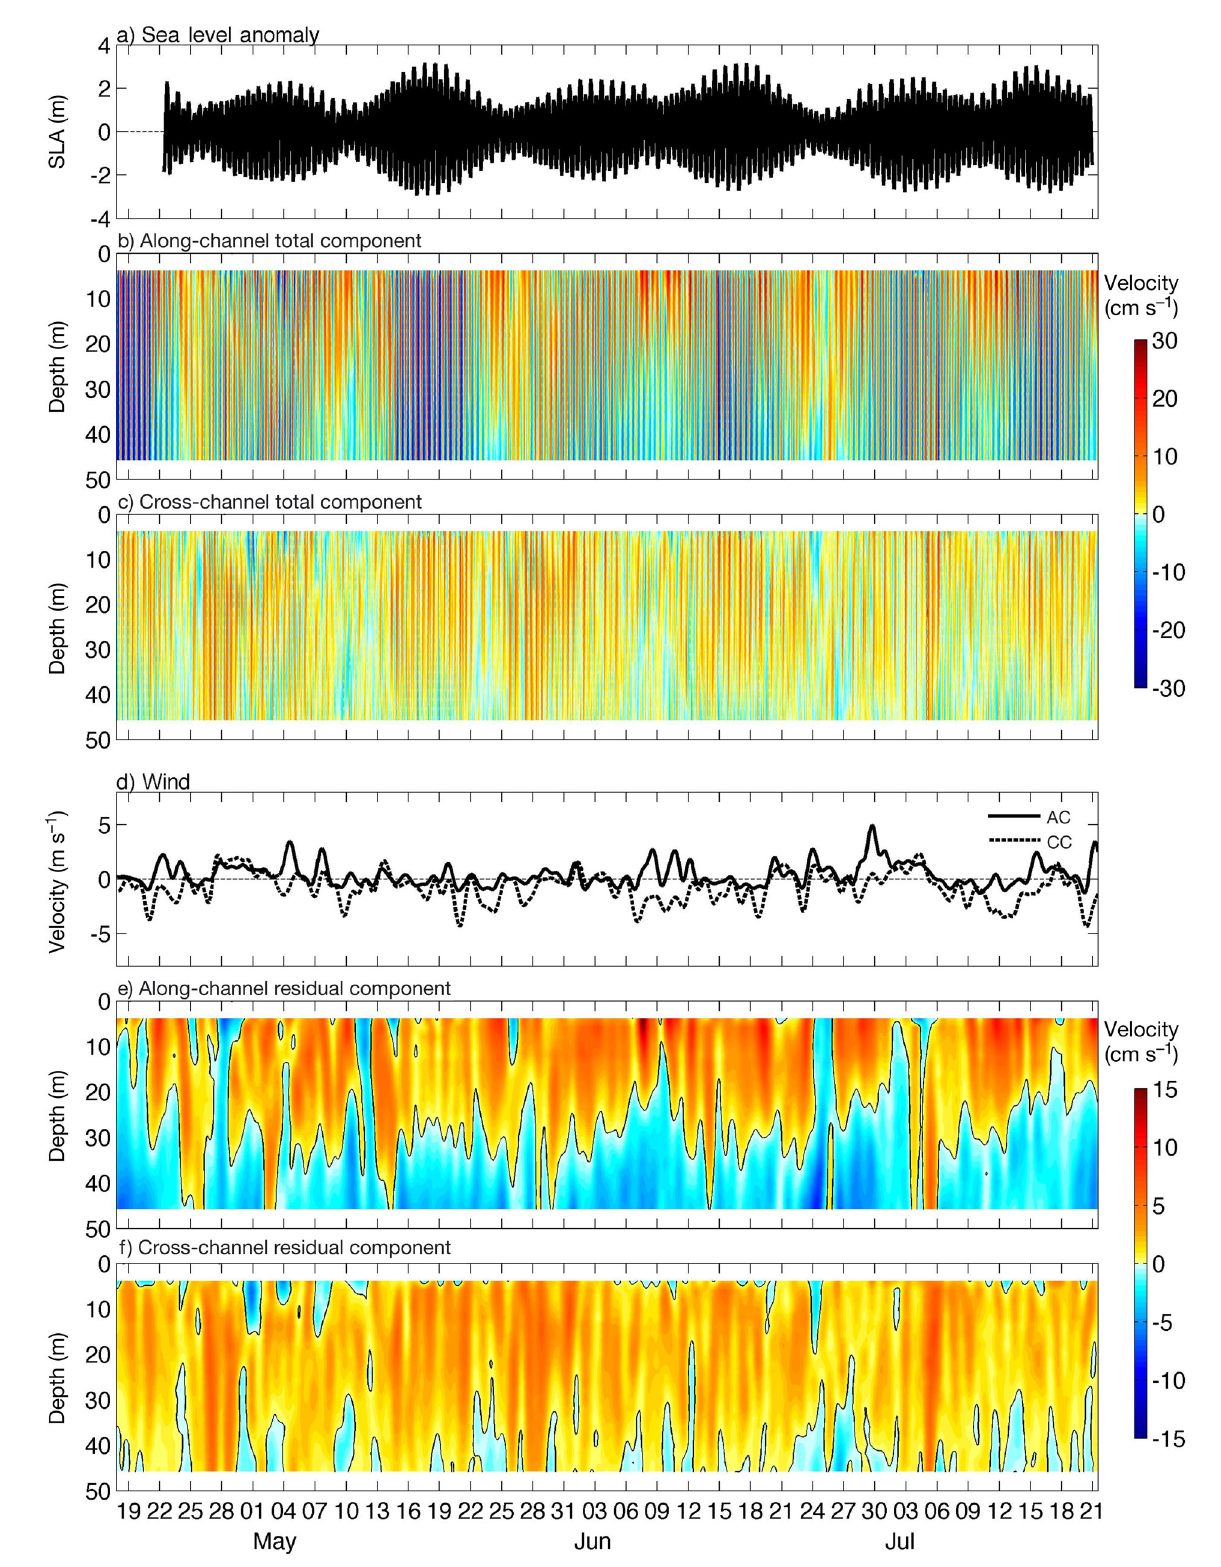
Fig. 7. (a) Sea level anomaly (SLA). (b,c) Cross- and along-channel component of the total currents. (d) Cross- (CC) and along-channel (AC) wind. (e,f) Cross- and along-channel residual currents. Data for 19 May and 21 July